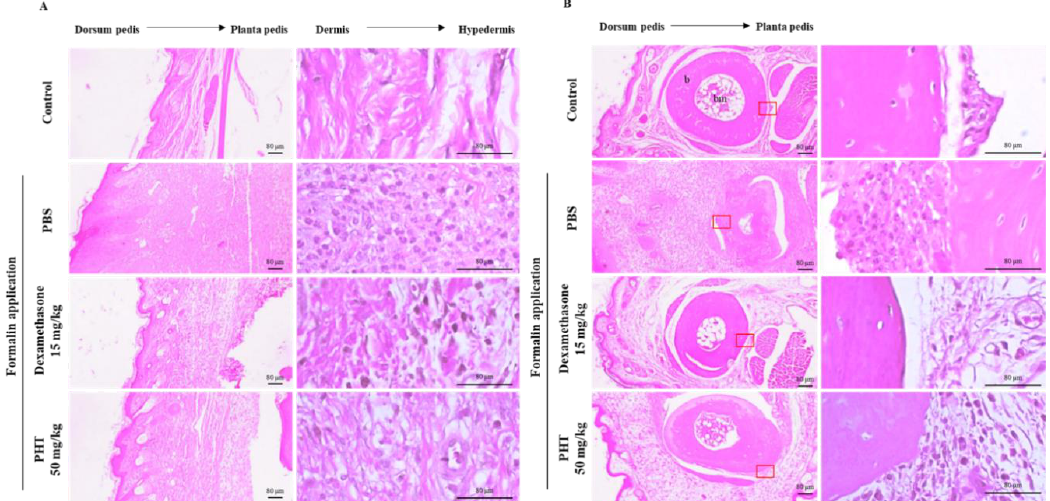
Figure 5. Histological analysis of induced paw ( A ) dorsum pedis skin and ( B ) digital skin. The paw was removed and fixed with 10% formalin. Then, samples were embedded in paraffin, sectioned with a microtome and stained with H&E. The data are representative of each group. b, bone; bm, bone marrow. Scale bars represent 80 μm as indicated.